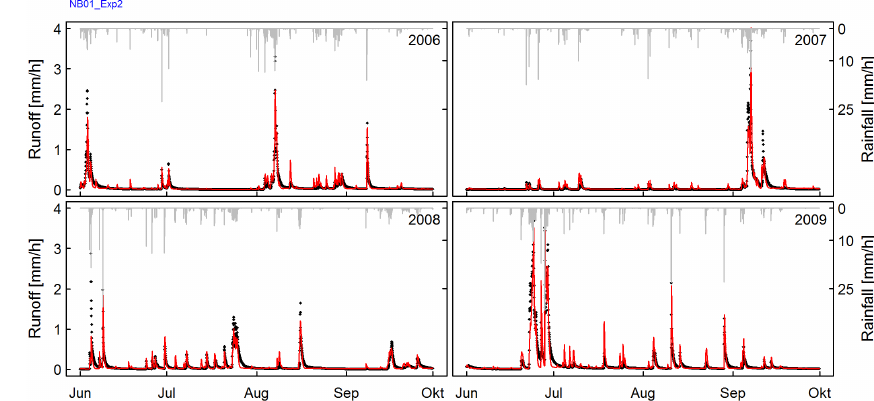
Figure 6. Schliefau catchment: observed (black points) and simulated (red) runoff of Exp 2 .